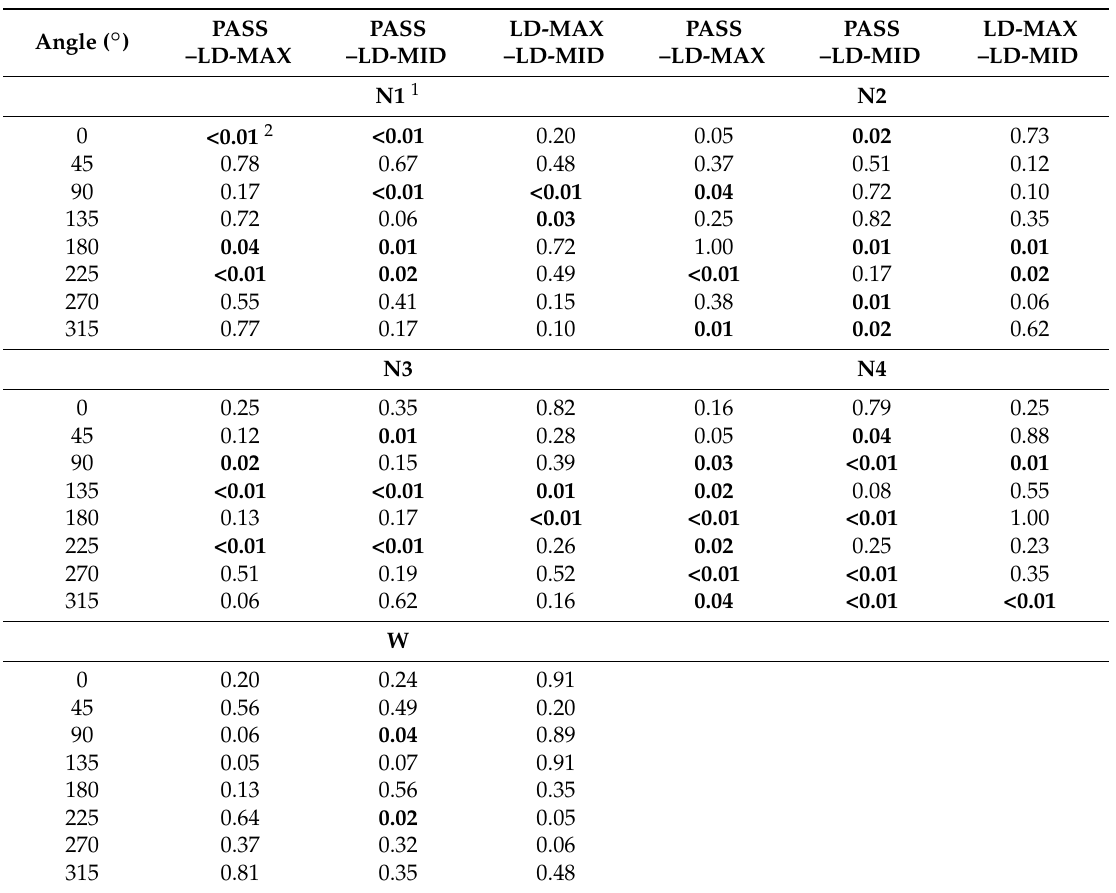
Table 1. Determined p -values for comparisons between different modes of using level-dependent hearing protectors for individual angles. PASS—with the level-dependent system switched off. LD-MAX—level-dependent mode, with maximum amplification in the sound transmission path; LD-MID—level-dependent mode with the amplification set to incomplete (approximately